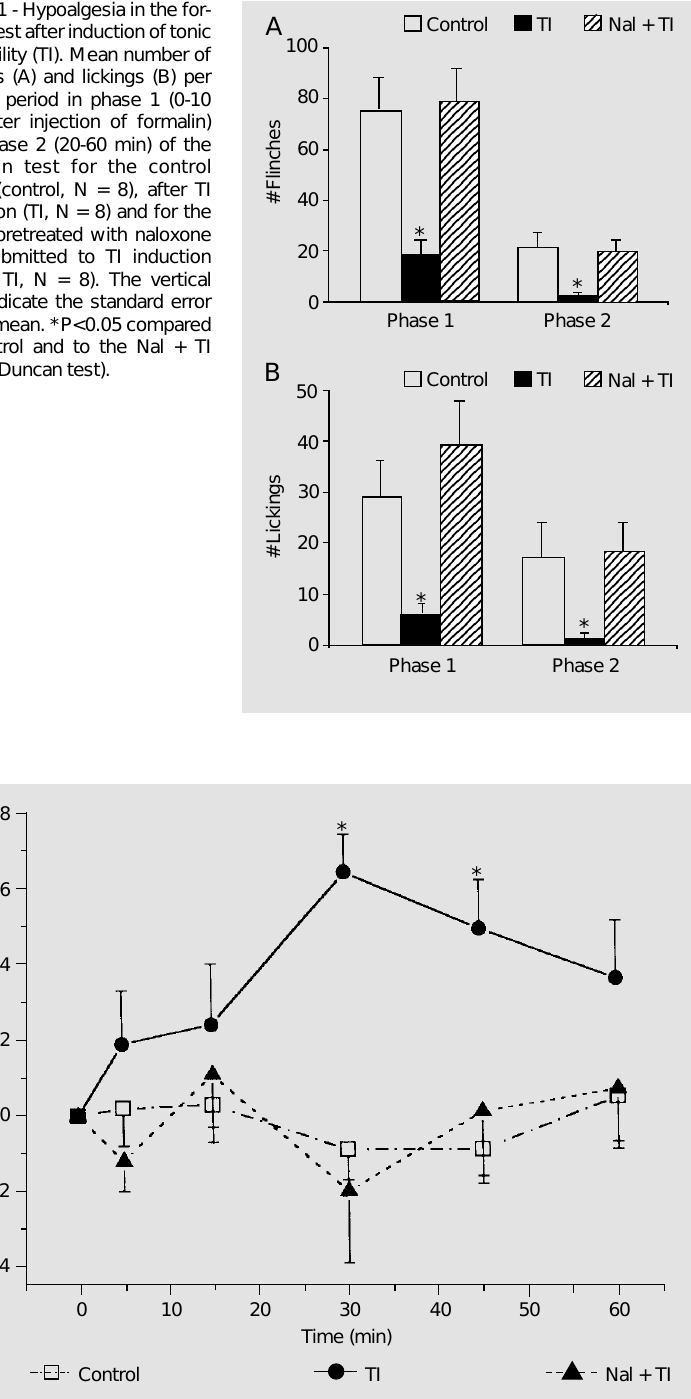
Figure 2 - Index of analgesia (IA) in the hot-plate test for the control group (control, N = 8), immediately after induction of the five episodes of tonic immobility (TI, N = 8), and for the group pretreated with naloxone and submitted to TI induction (Nal + TI, N = 8). Time zero represents the baseline and the vertical bars indicate the standard error of the mean. *P<0.05 compared to control and to the Nal + TI group (Duncan